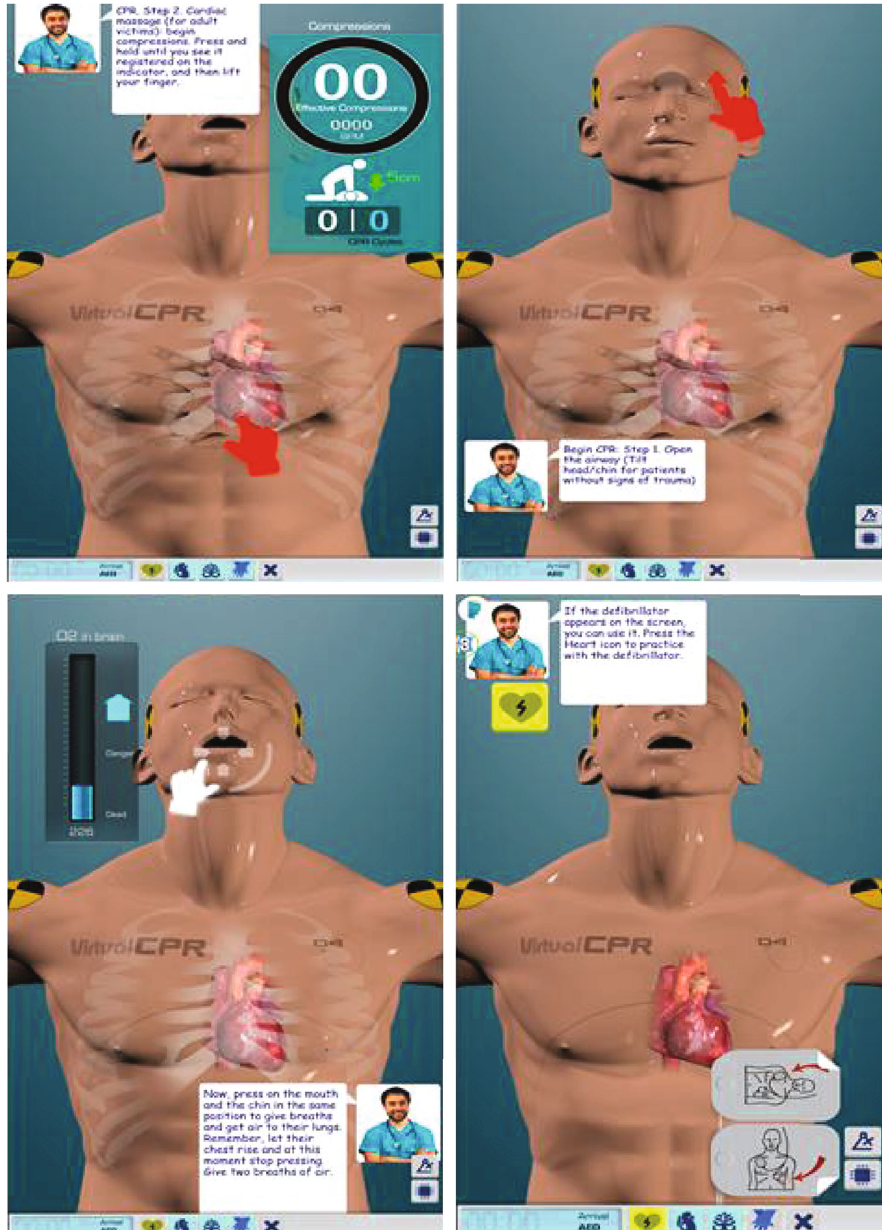
Figure 1: A screenshot of CPR training using a serious game by the Virtualware Group